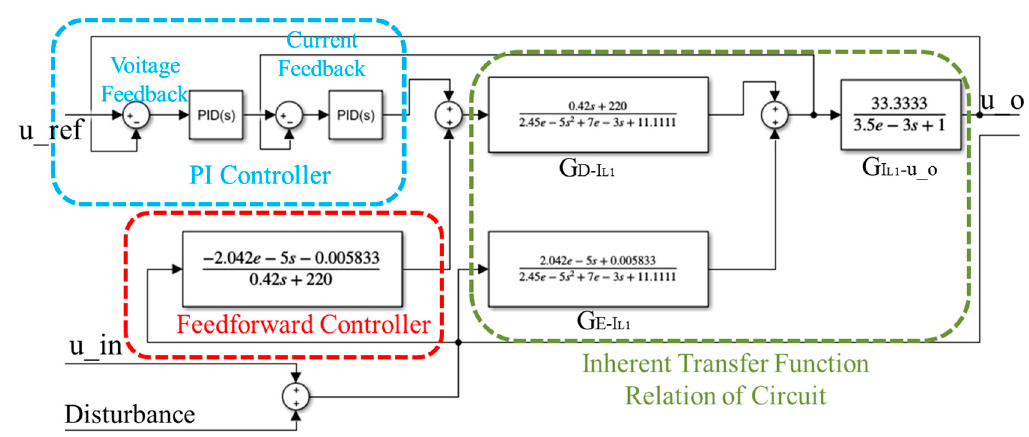
Figure 11. Dual-switch boost converter simulation model.